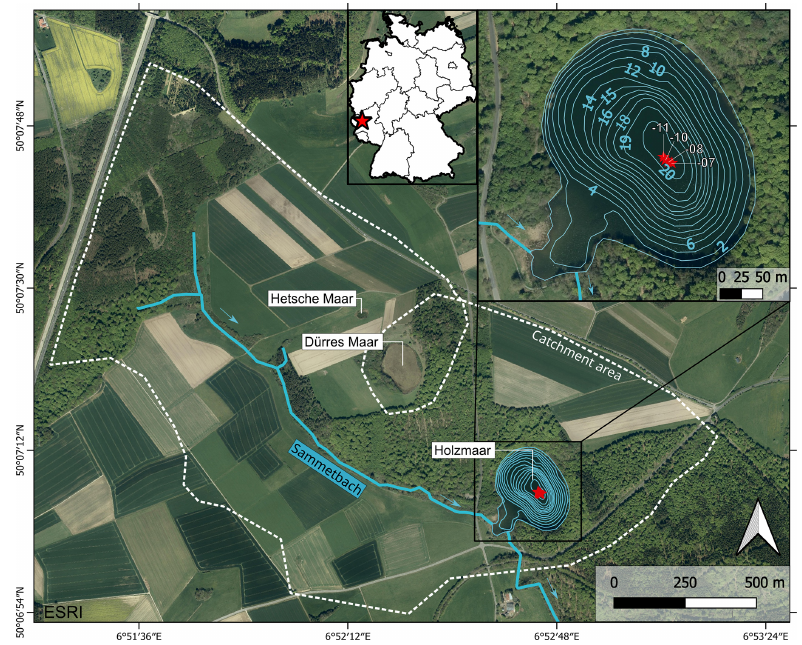
Figure 1. ESRI Satellite image of the Holzmaar volcanic system and its catchment area (indicated by a dashed white line) with Holzmaar, Dürres Maar, Hetsche Maar, and Sammetbach (blue line, flow direction indicated by arrows). The upper left insert shows the location of Holzmaar in Germany (red star). The upper right insert shows bathymetric map with isobaths in metres and coring locations (HZM19-07, -08, -10, and -11) marked by red